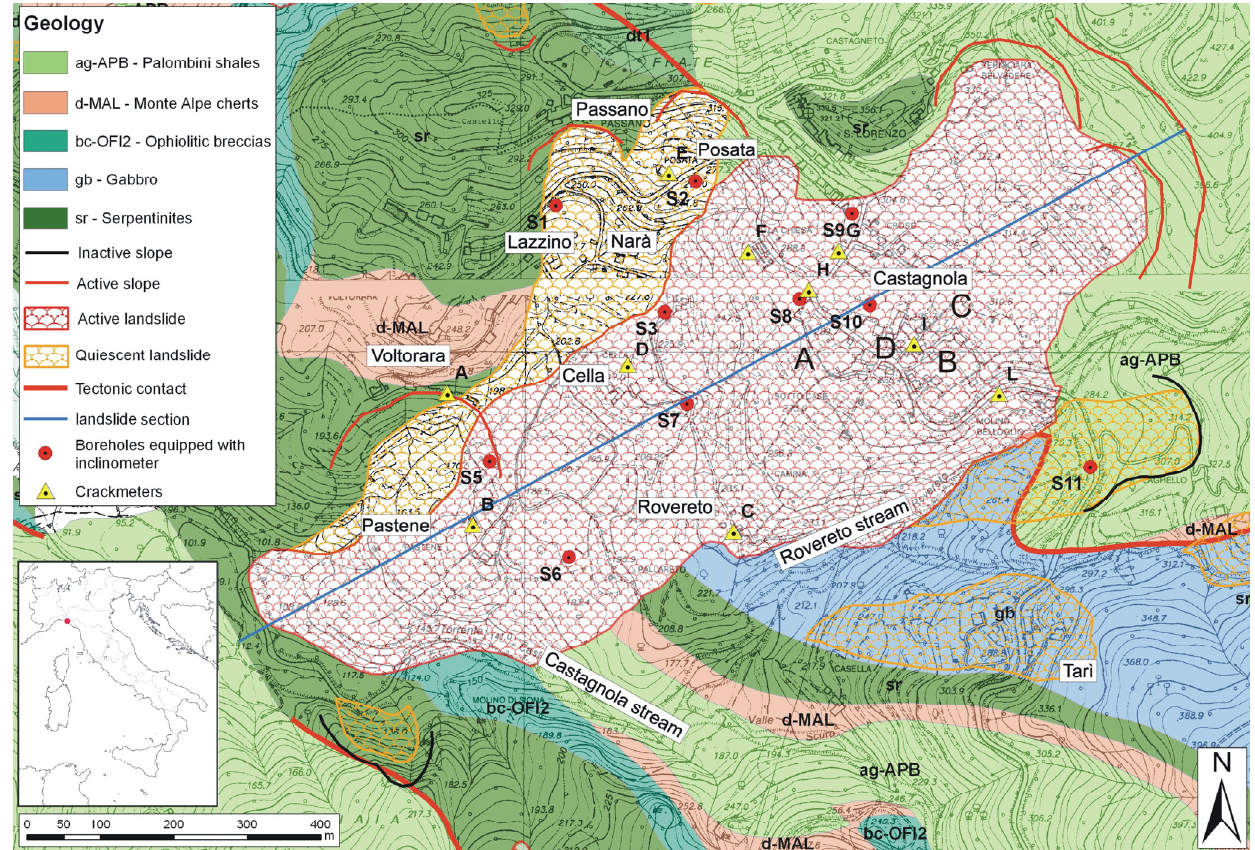
Figure 1. Geologic and geomorphologic map of Castagnola area with location of the in-situ instrumentation and landslide perimeter as mapped in the PAI (Hydrogeological Setting